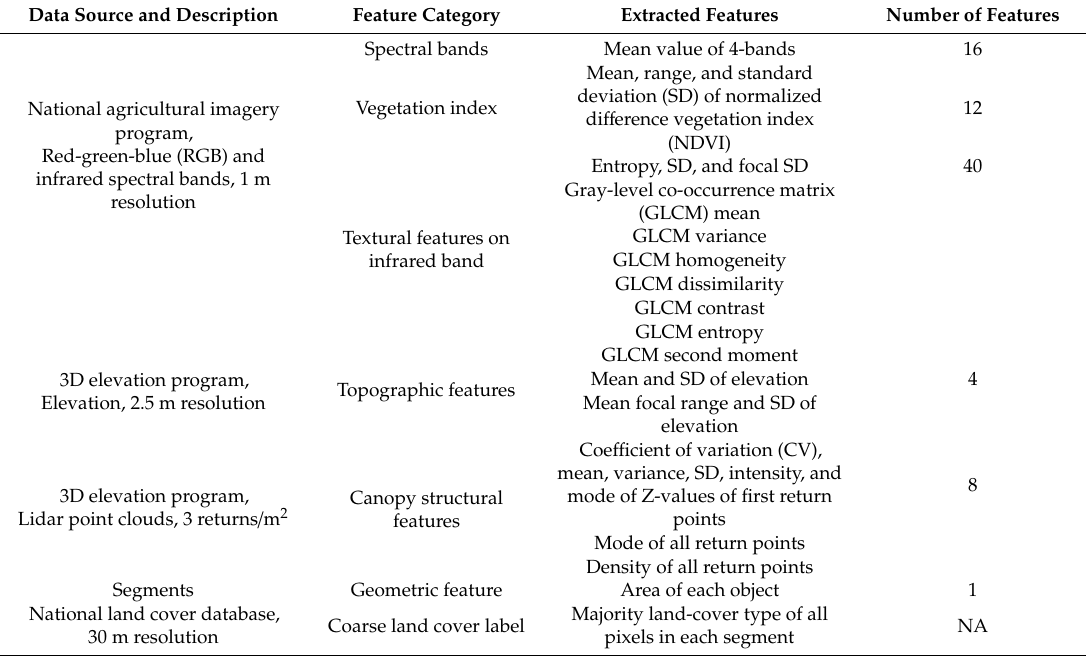
Table 1. Source and description of data and details on features used for kudzu